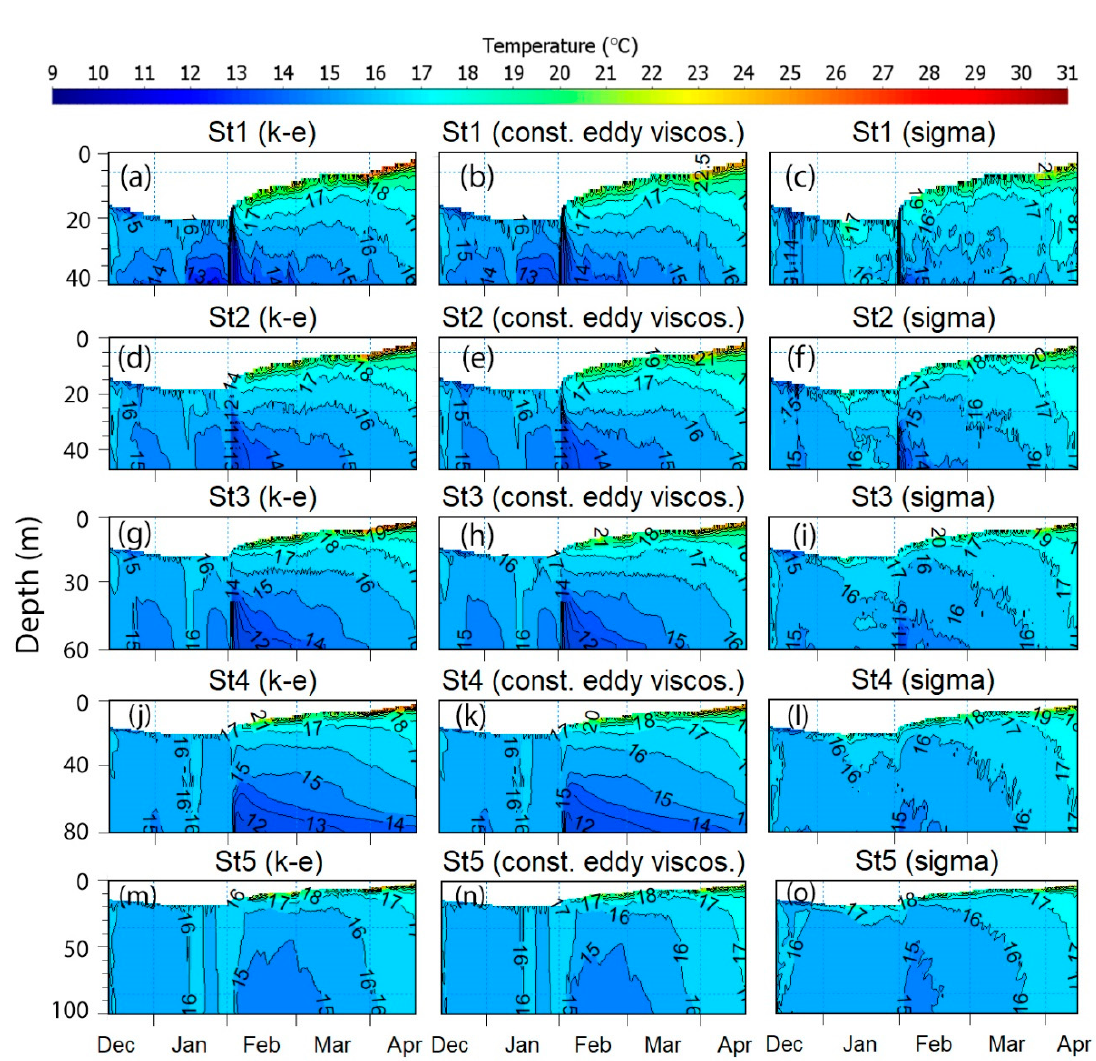
Figure 12. Temporal variations of the simulated water temperature by MIKE3 with different model discretizations and turbulence models as profiles of water column temperature at measurement locations in the Maroon Reservoir.